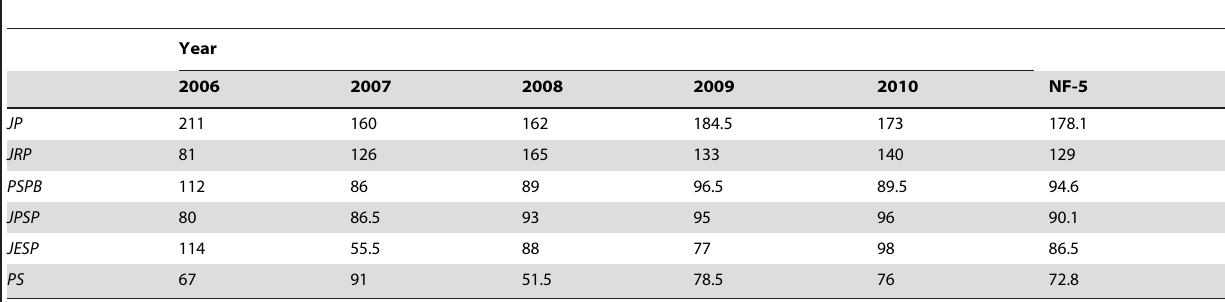
Table 2. Median Sample Sizes for each Six Empirical Journals in Social/Personality Psychology.